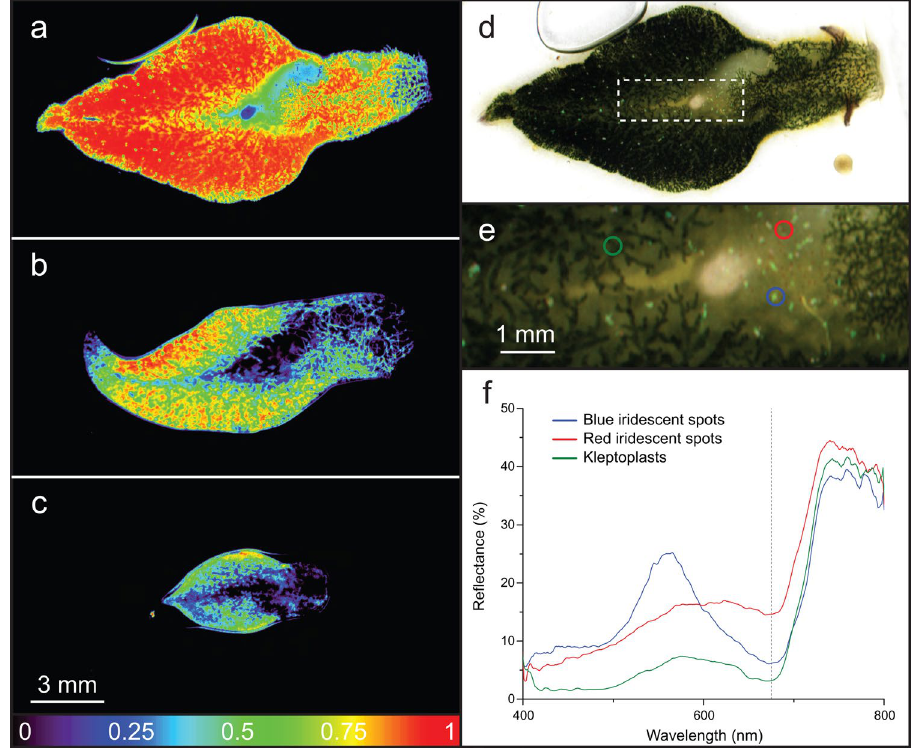
Figure 4. Hyperspectral imaging of Elysia viridis . Normalized difference vegetation index (NDVI) images of animals feeding on Codium tomentosum ( a ), and starved for 24 days under 14:10 h light:dark cycles ( b ) and in continuous darkness ( c ). RGB image representing “true” colors of the control after 24 days ( d ). Close-up of area represented in the white box of panel (d), with color-coded AOI’s for kleptoplasts, and red and blue iridescent spots ( e ), and extracted spectral characteristics seen in ( f ). Scale bar in panel (c) applies to the images in panels (a–d).